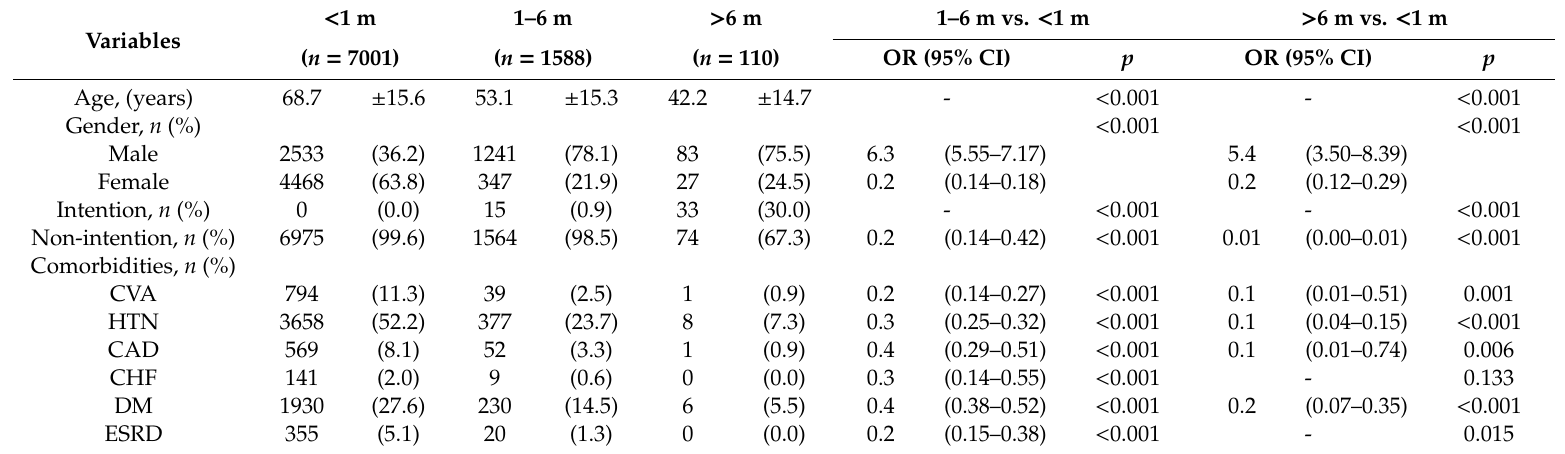
Table 1. Demographics characteristics of patients with falls from heights of < 1 m (m), 1–6 m, and > 6